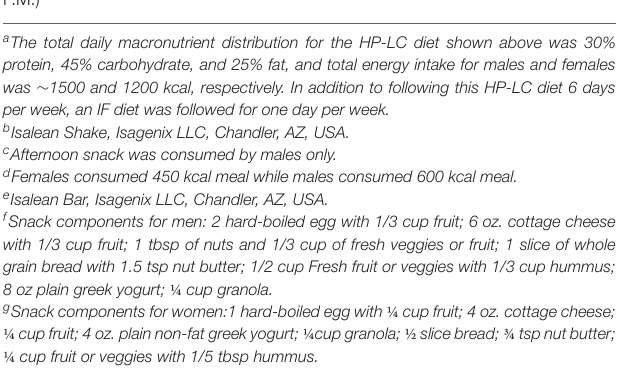
TABLE 2 | Composition of intermittent fasting diet. Food item/dietary